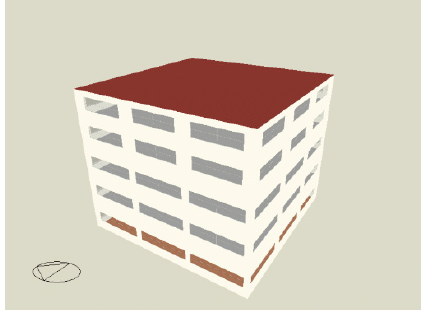
Figure 11. Validation building, shape 5.